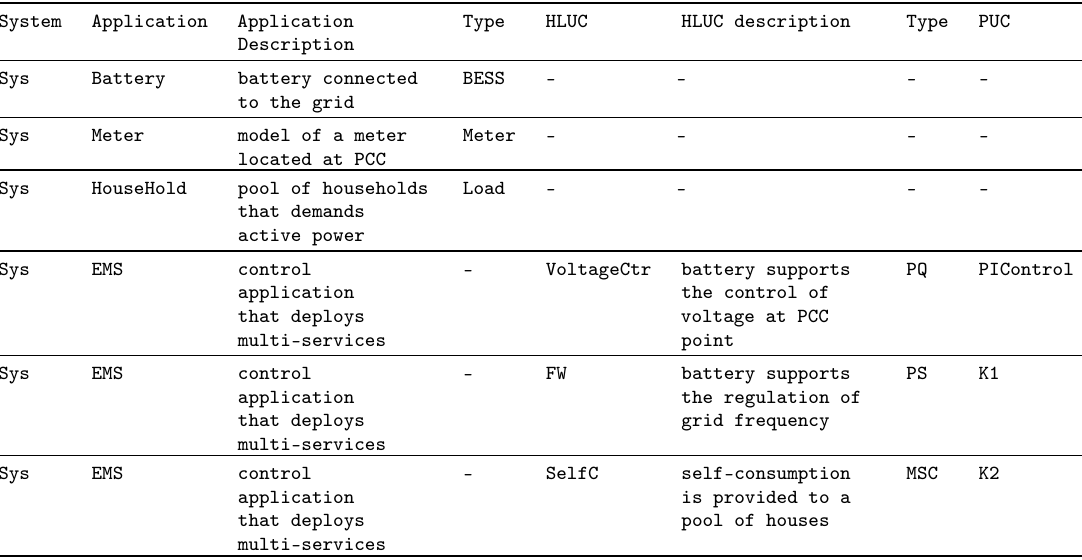
Table 5. Structure of an EMS (e.g., UC5).